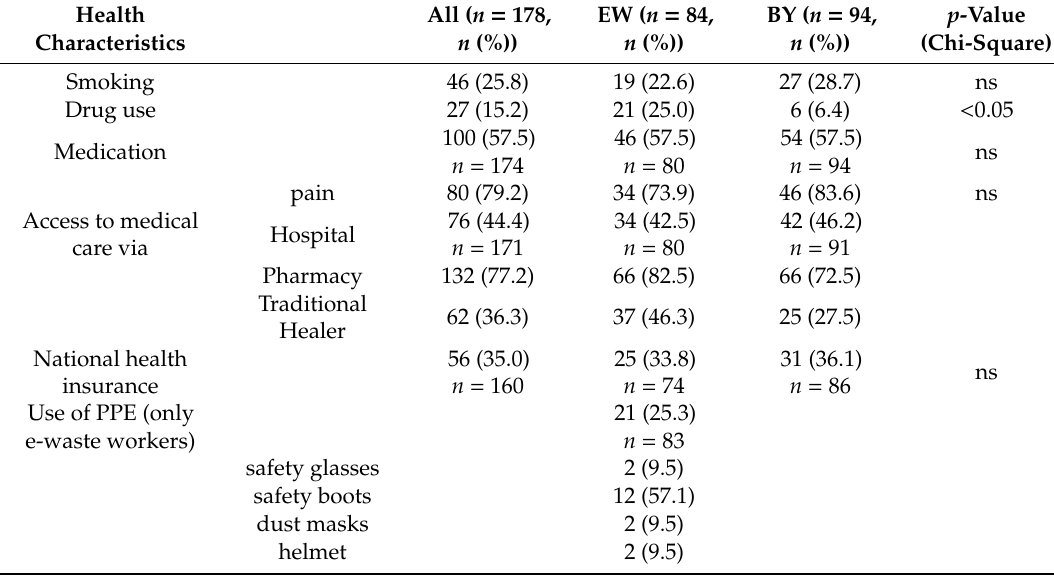
Table 2. Selected health characteristics of the e-waste workers and bystanders on the Agbogbloshie scrap yard.